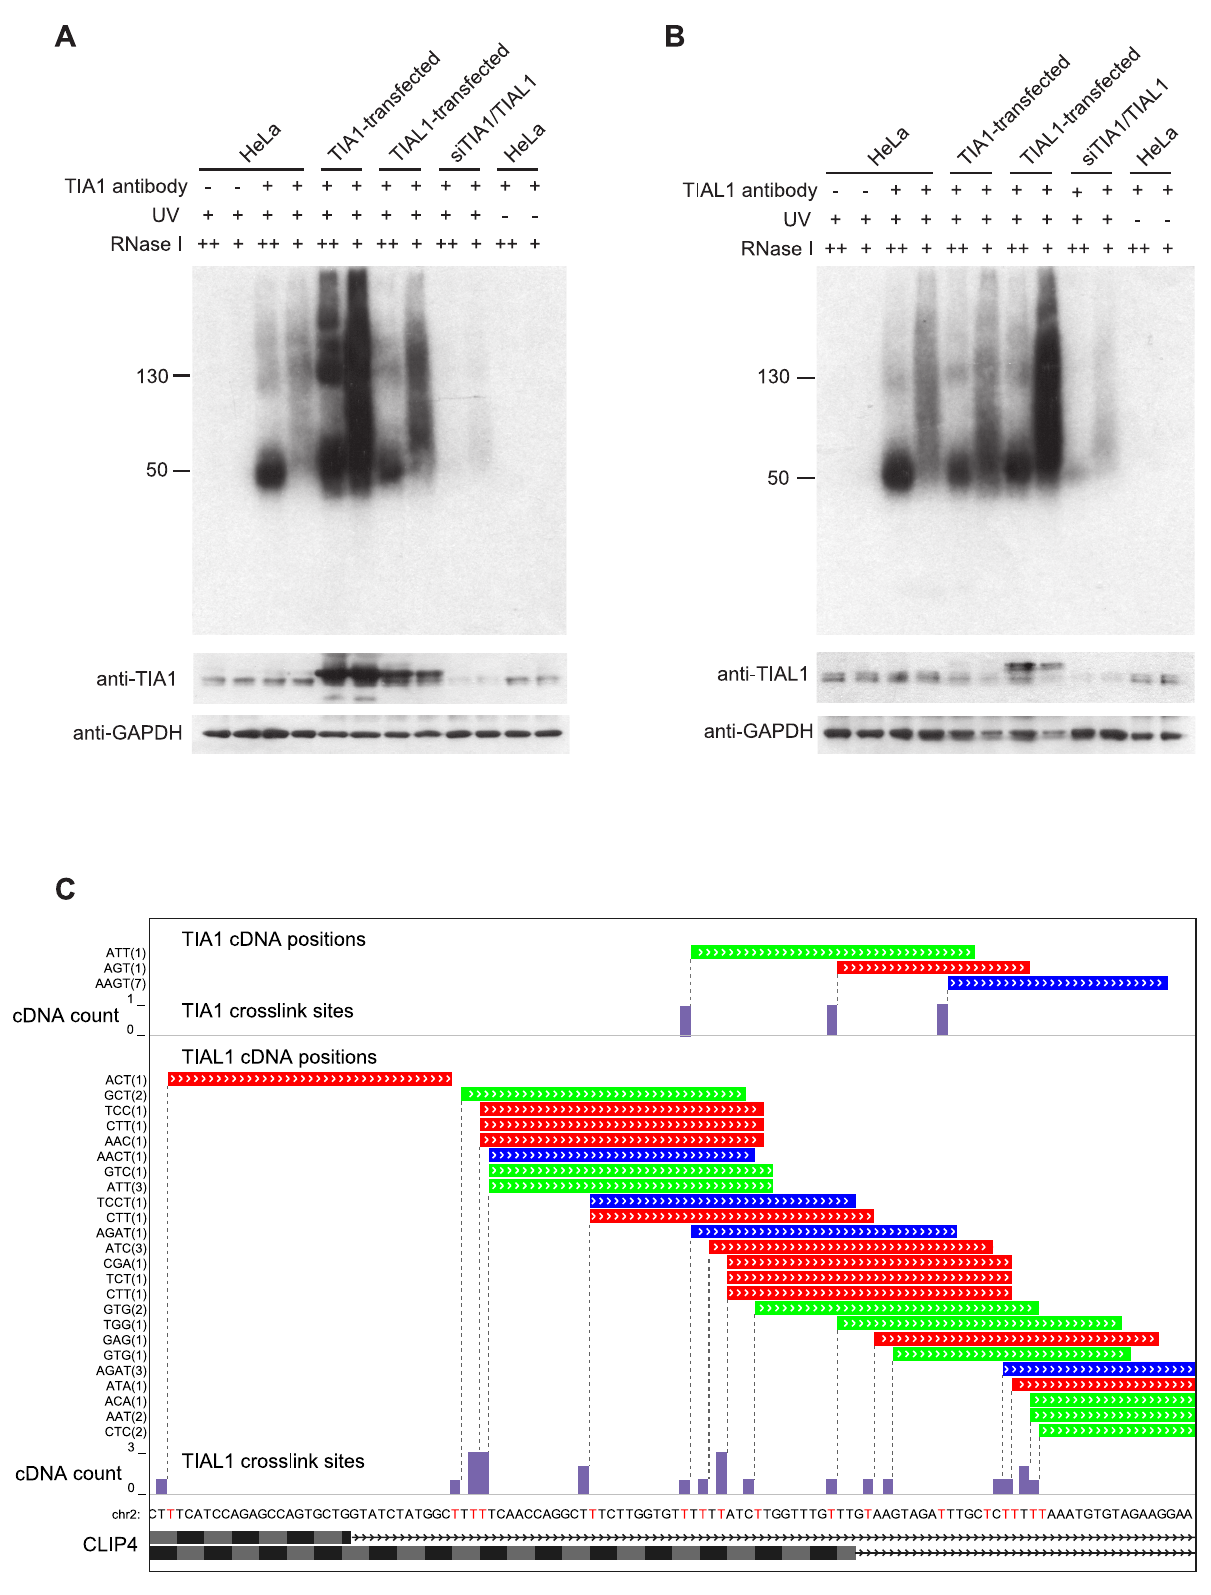
Figure 1. iCLIP identifies the TIA1 and TIAL1 crosslink sites with nucleotide resolution. Autoradiogram of 32 P-labelled RNA crosslinked to TIA1 (A) or TIAL1 (B) in HeLa cells. Immunoprecipitation was performed with either anti-TIA1 or anti-TIAL1 antibody using lysate from UV-crosslinked HeLa cells, cells transfected with TIA1 or TIAL1, TIA1/TIAL1 KD cells, or non-crosslinked cells. High and low RNase concentrations were used and protein G beads were used as a control. The Western blots below the autoradiograms show the input lysate used for each immunoprecipitation. (C)